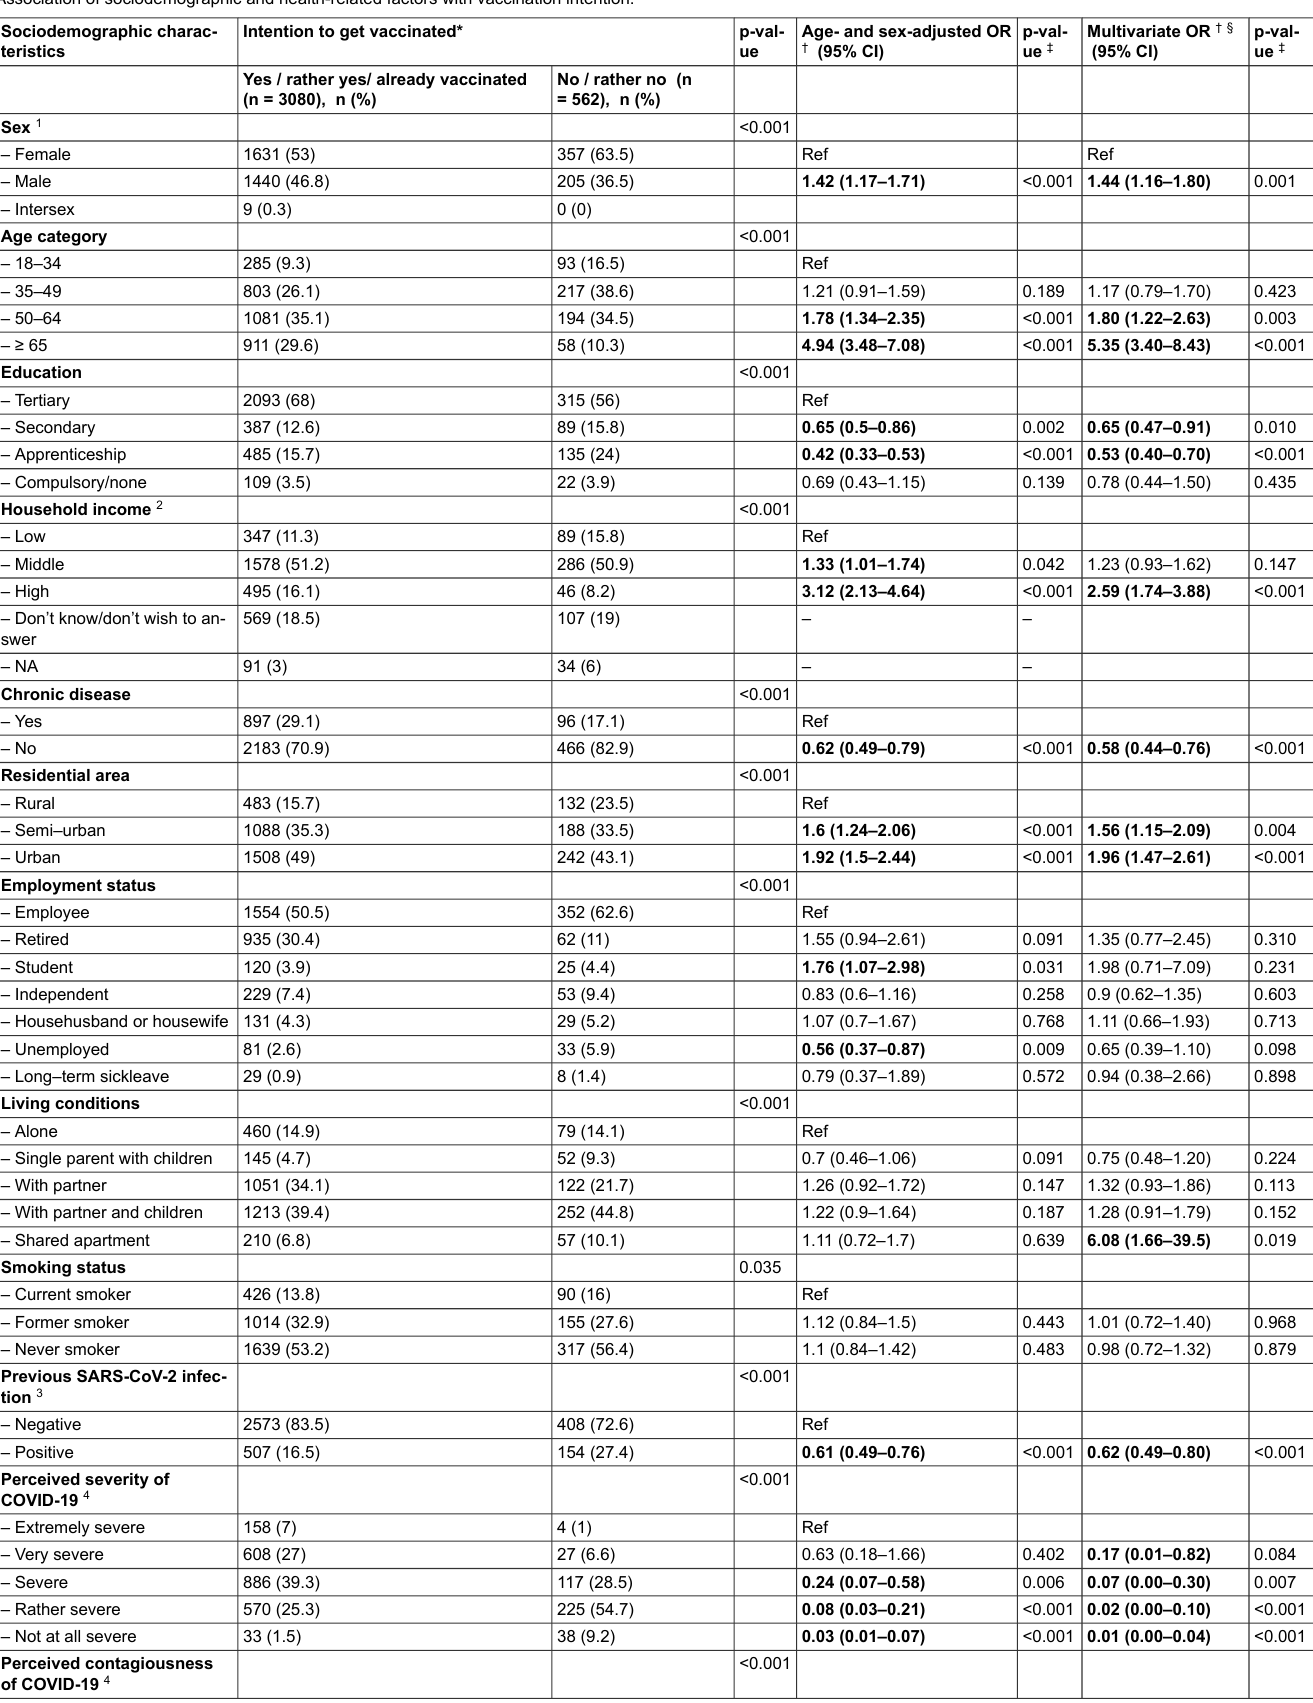
Table 4: Association of sociodemographic and health-related factors with vaccination intention. Sociodemographic charac-